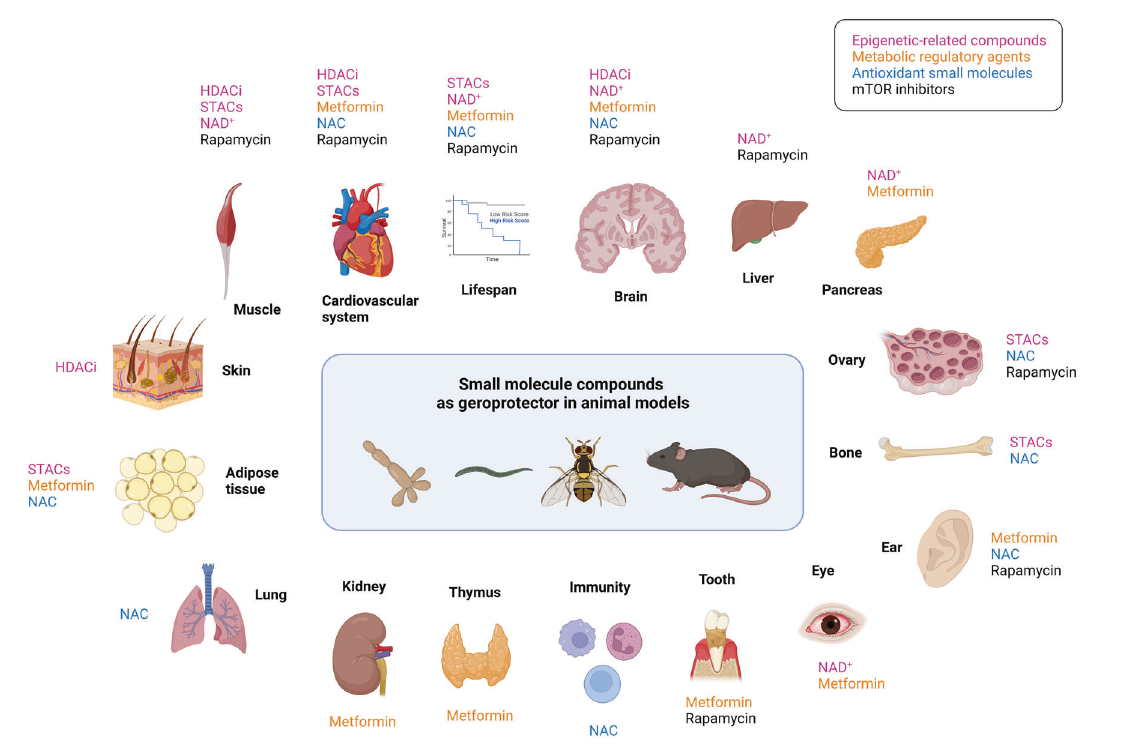
Fig. 8 Small molecule compounds as geroprotectors in diverse animal models. A series of small molecule compounds can extend the lifespan or alleviate aging-related phenotypes in different organs. The interventions and corresponding target organs are shown in the